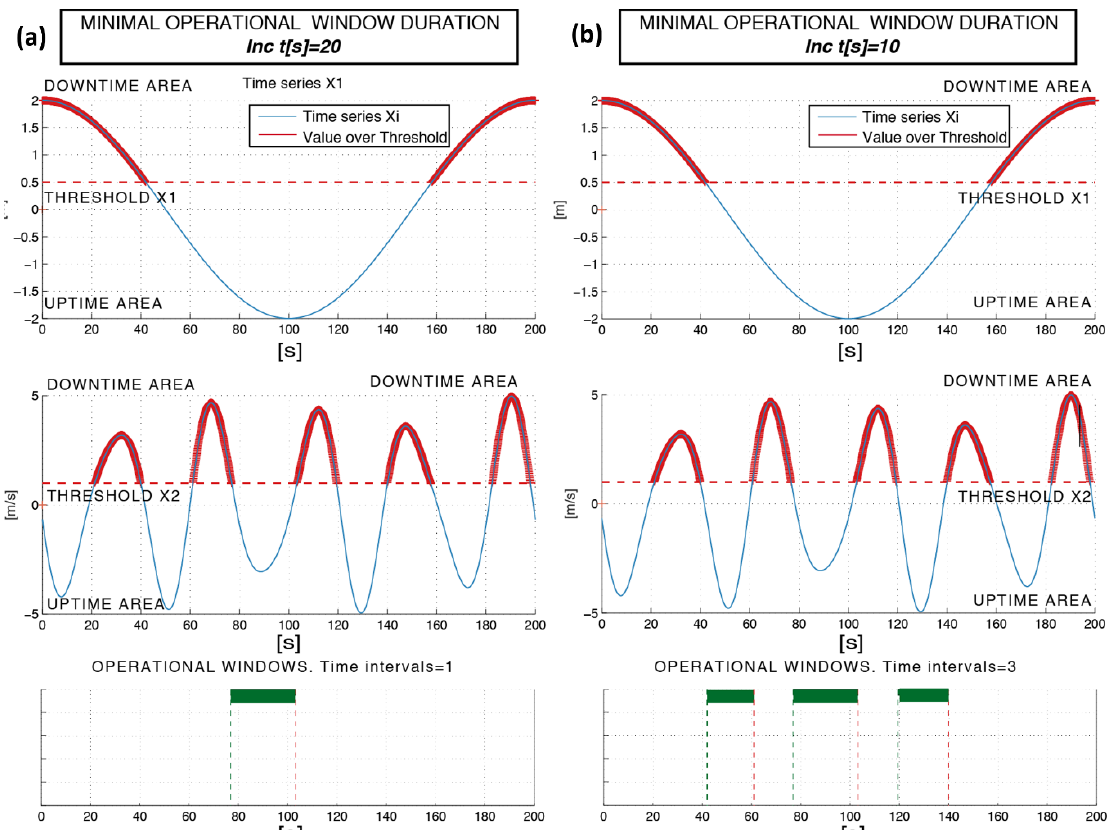
Figure 8. Scheme of an operational analysis based on conditioned thresholding on two variables. Notice that the operational windows depends on the minimal operational duration and on having both variables below their own limit condition. ( a ) Results for a minimal operational window of 20 s; ( b ) Results for a minimal operational window of 10 s. Own elaboration.